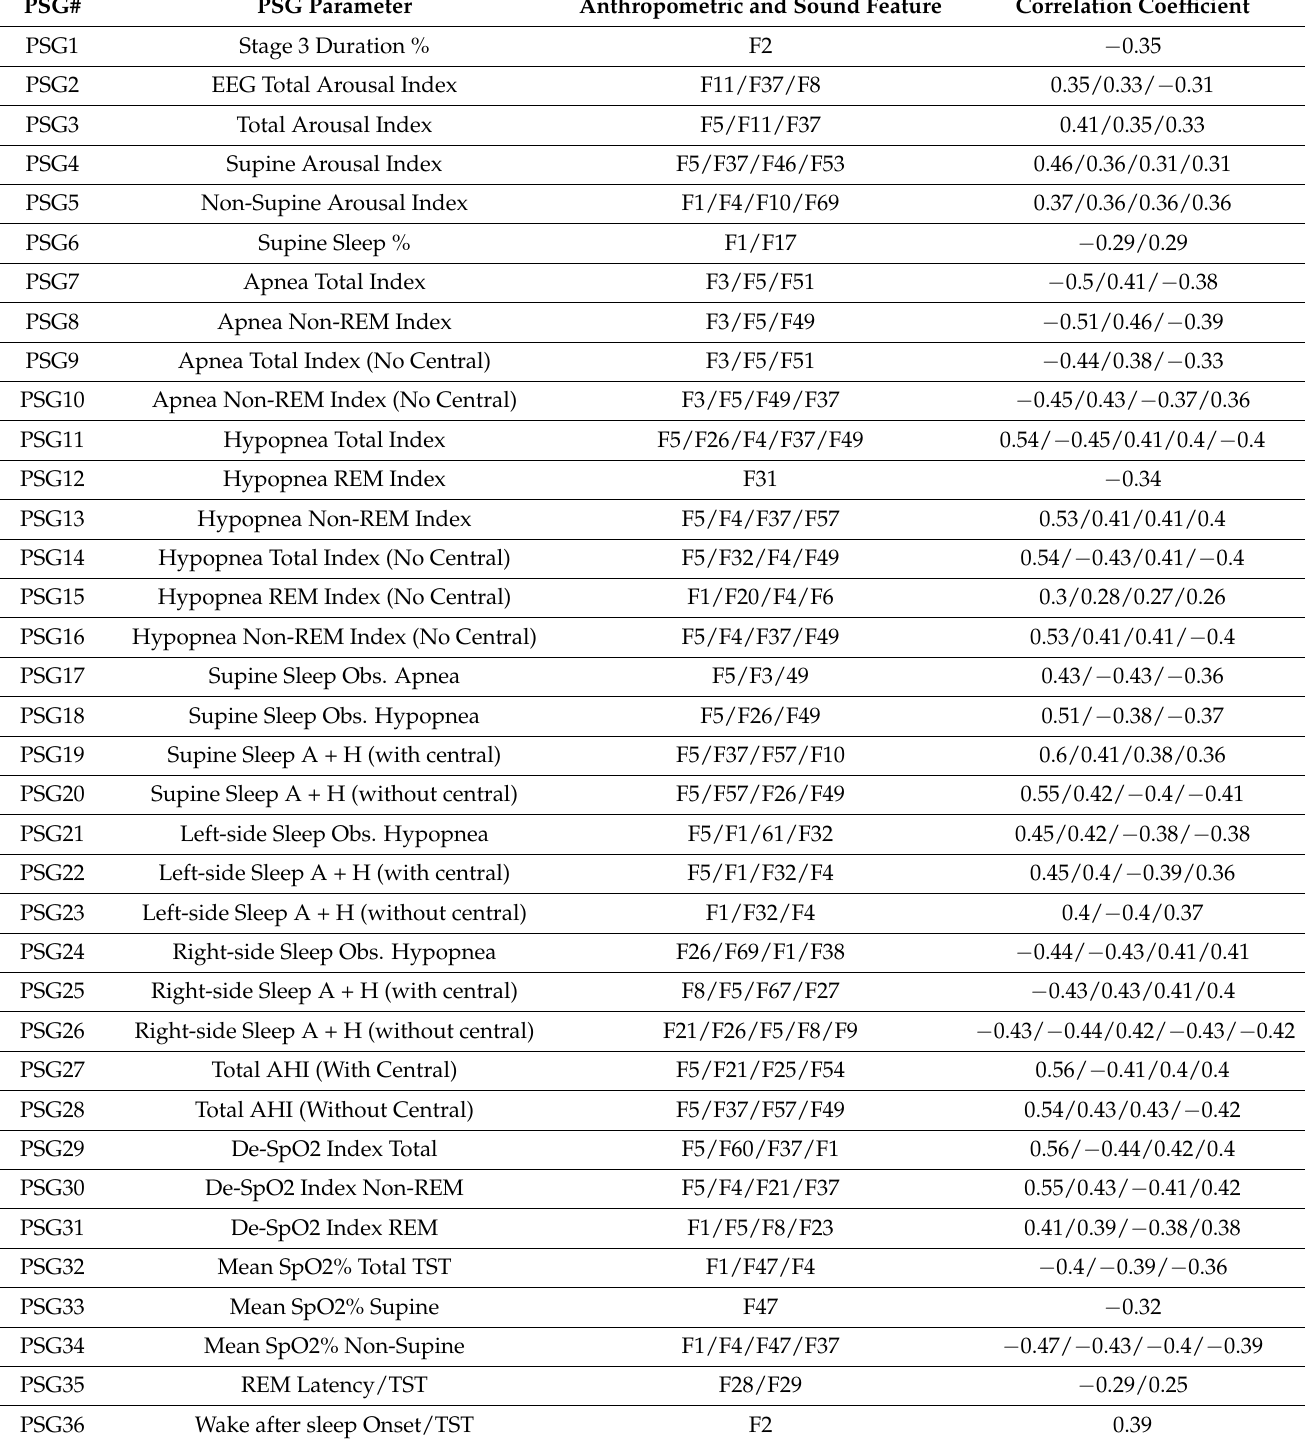
Table 3. The spearman correlation coefficients between the anthropometric/sound feature and the PSG